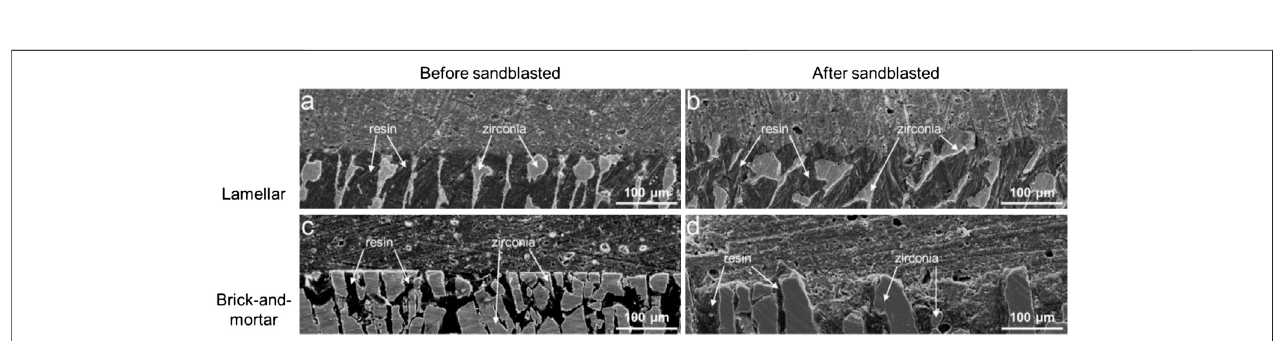
FIGURE 7 | SEM images of the bonding interfaces with resin for the Lamellar and Brick-and-mortar groups before and after sandblasted.